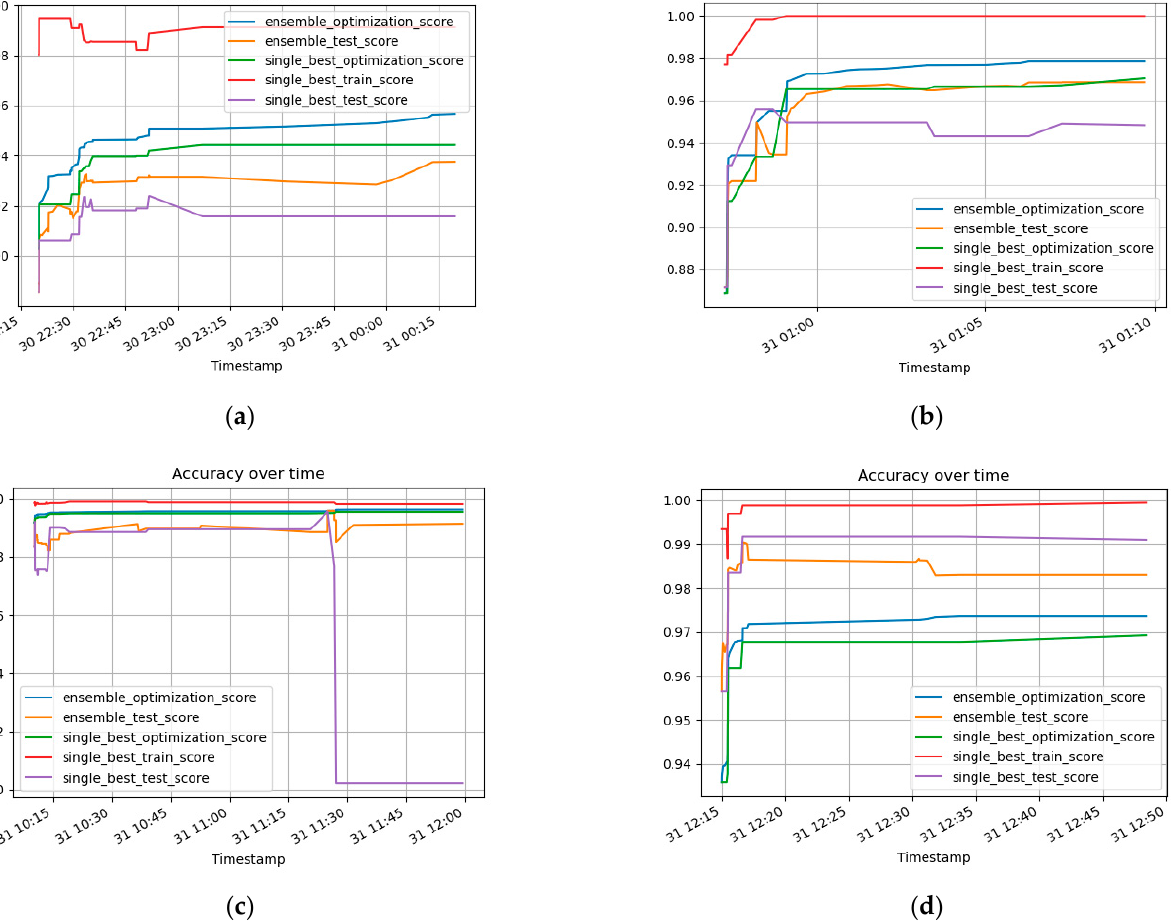
Figure 7. The 𝑅 (cid:2870) curves of Auto-Sklearn during training on the four datasets. ( a ) CC dataset, ( b ) RHA dataset, ( c ) HSC dataset, and ( d ) MSC dataset. Table 6. Four optimal models searched by Auto-Sklearn.